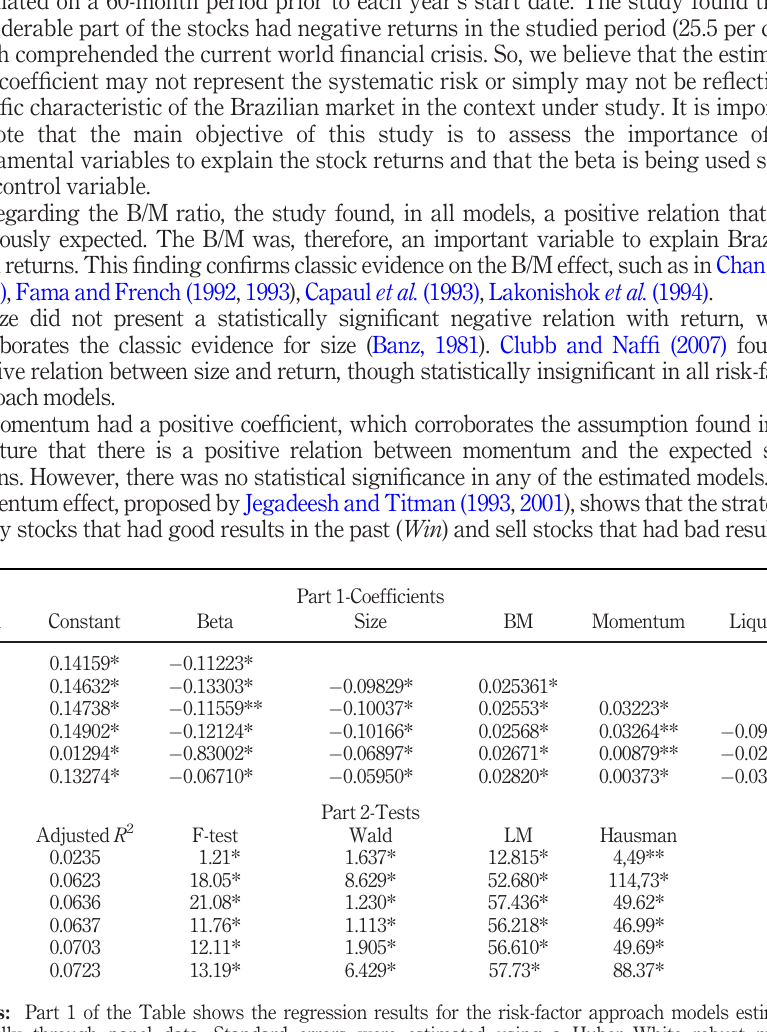
Table VIII. Regression results for the risk-factor approach